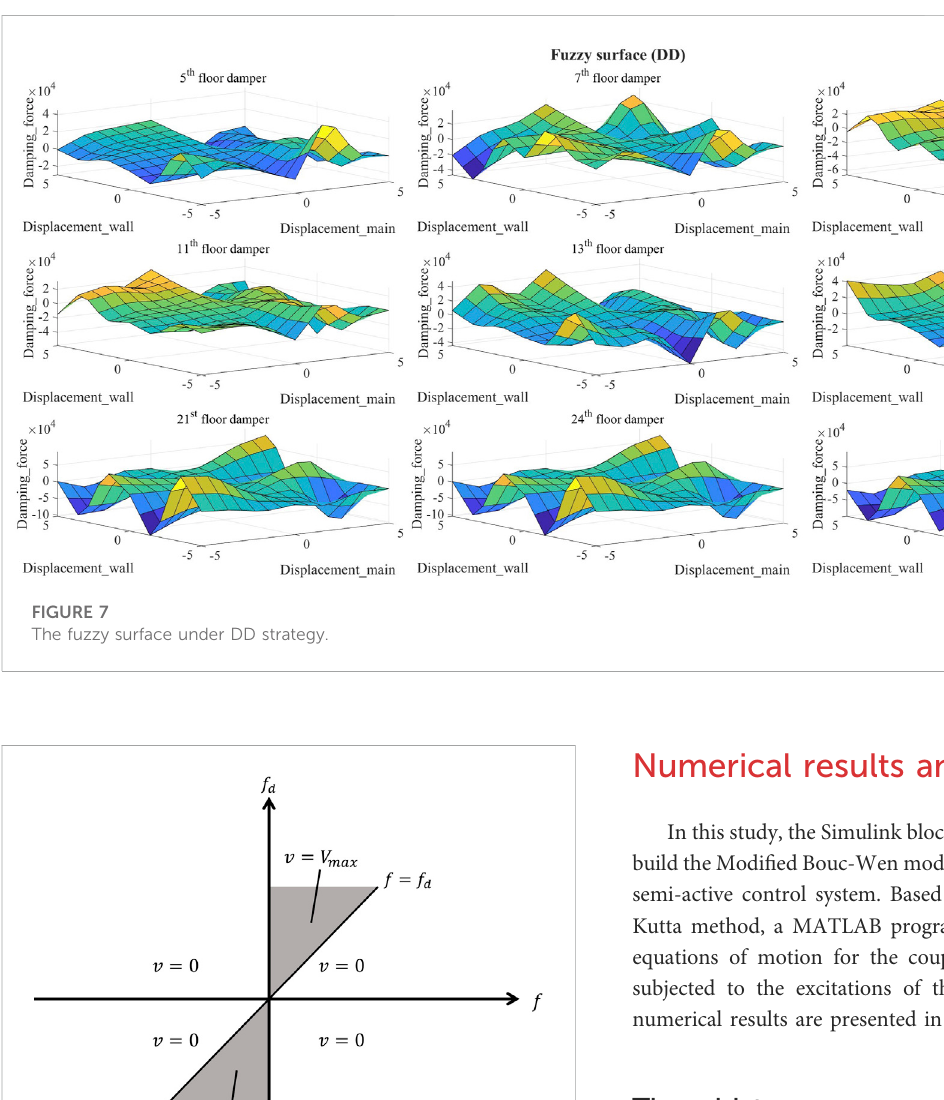
FIGURE 8 Graphical representation of algorithm (Dyke et al.,